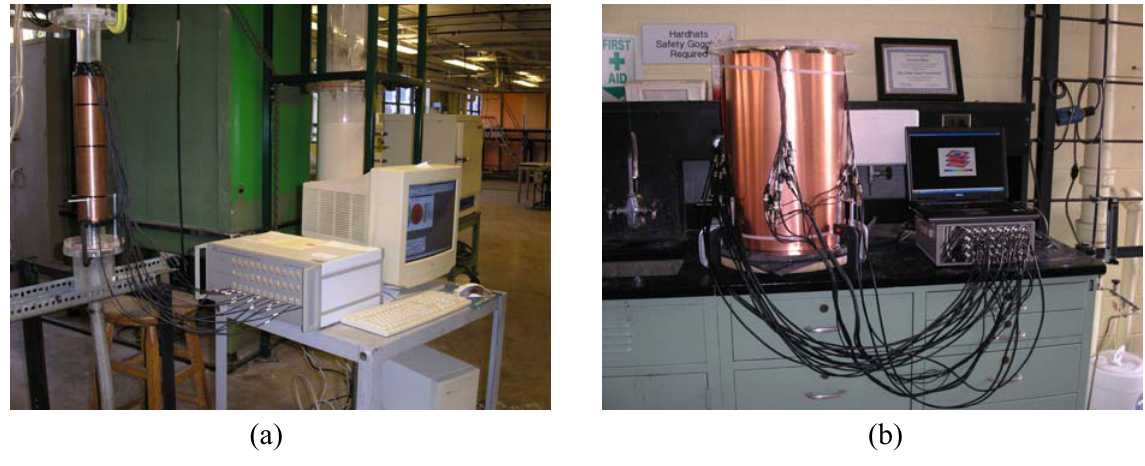
Figure 11. ECVT sensors with multiple channels: (a) 12-channel sensor; (b) 32-channel